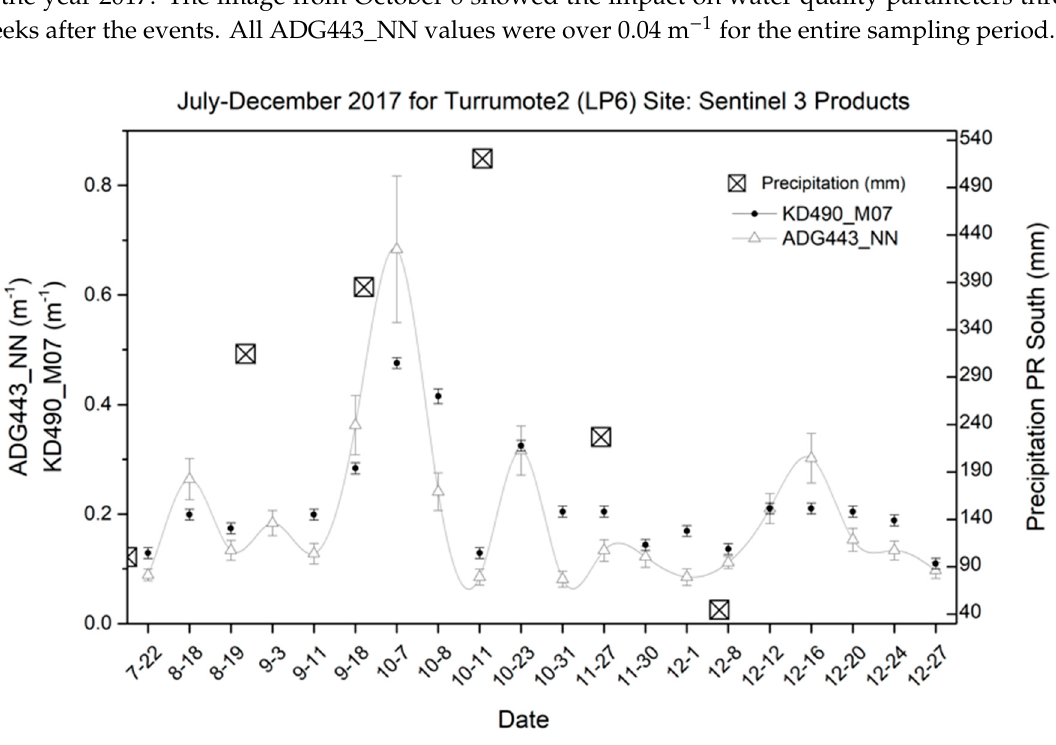
Figure 5. S3A OLCI products from July to December 2017 showing the changes over time for station LP6 known as Turrumote II (located between Guánica Bay (GB) and La Parguera Natural Reserve (LPNR)) for ADG443_NN and K d 490_M07 and monthly precipitation at Guayanilla, Puerto Rico (PR) south station.